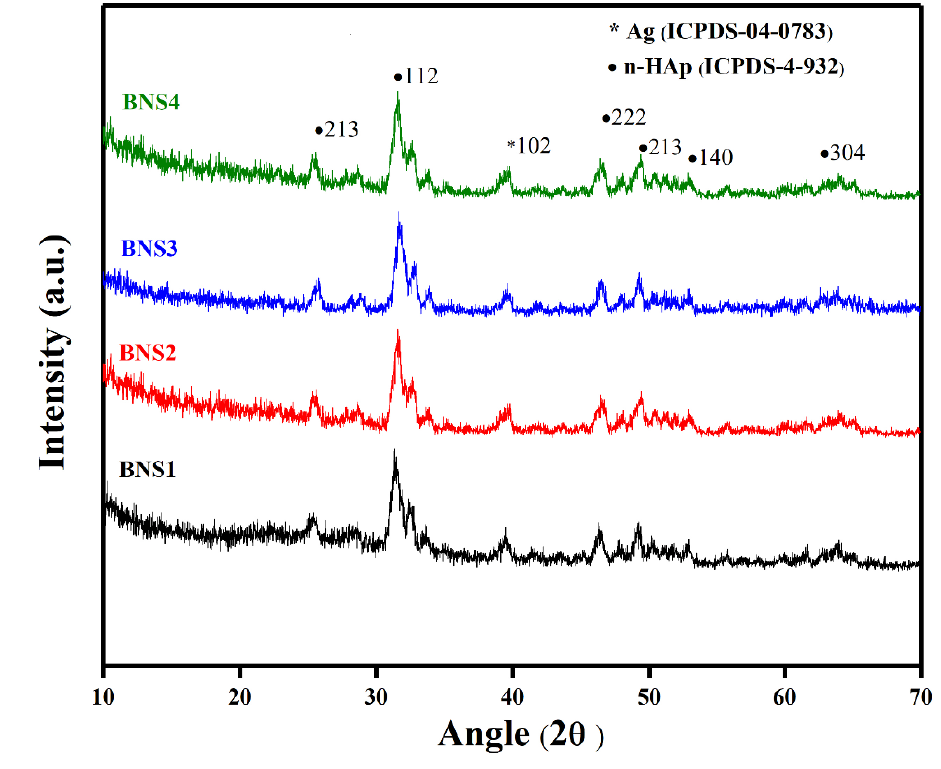
Figure 2. Fourier transform infrared spectroscopy (FTIR) spectral profiles show various functional groups along with their different modes of vibrations available in the